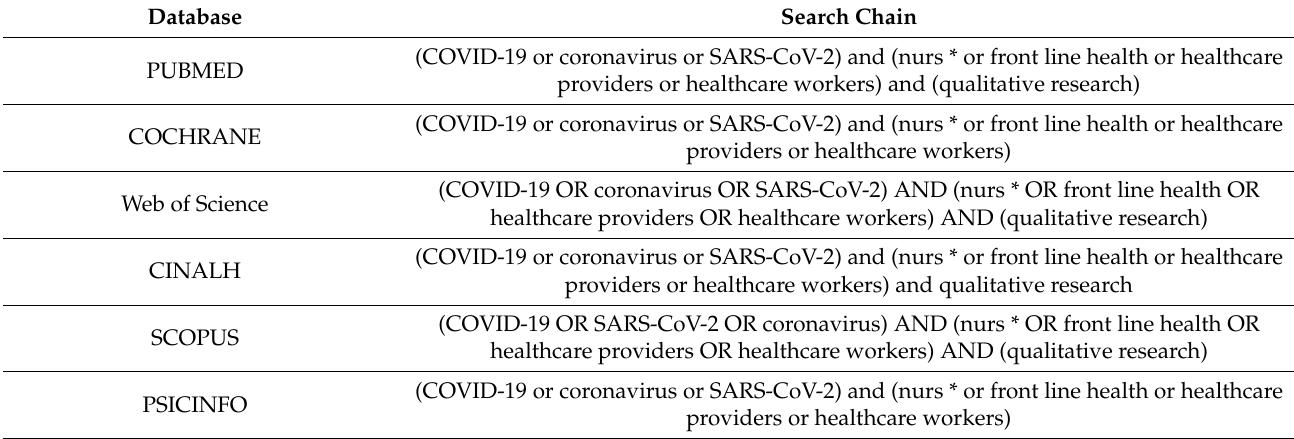
Table 1. Search strategy in the selected